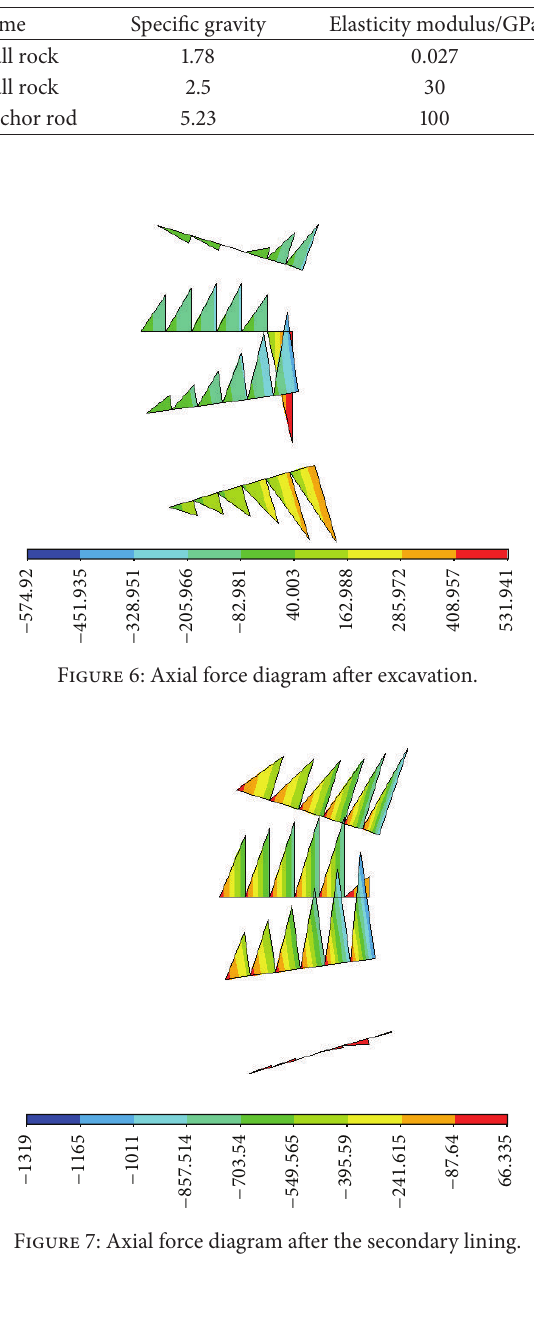
Table 2: Parameters of wall rock and tunnel lining.